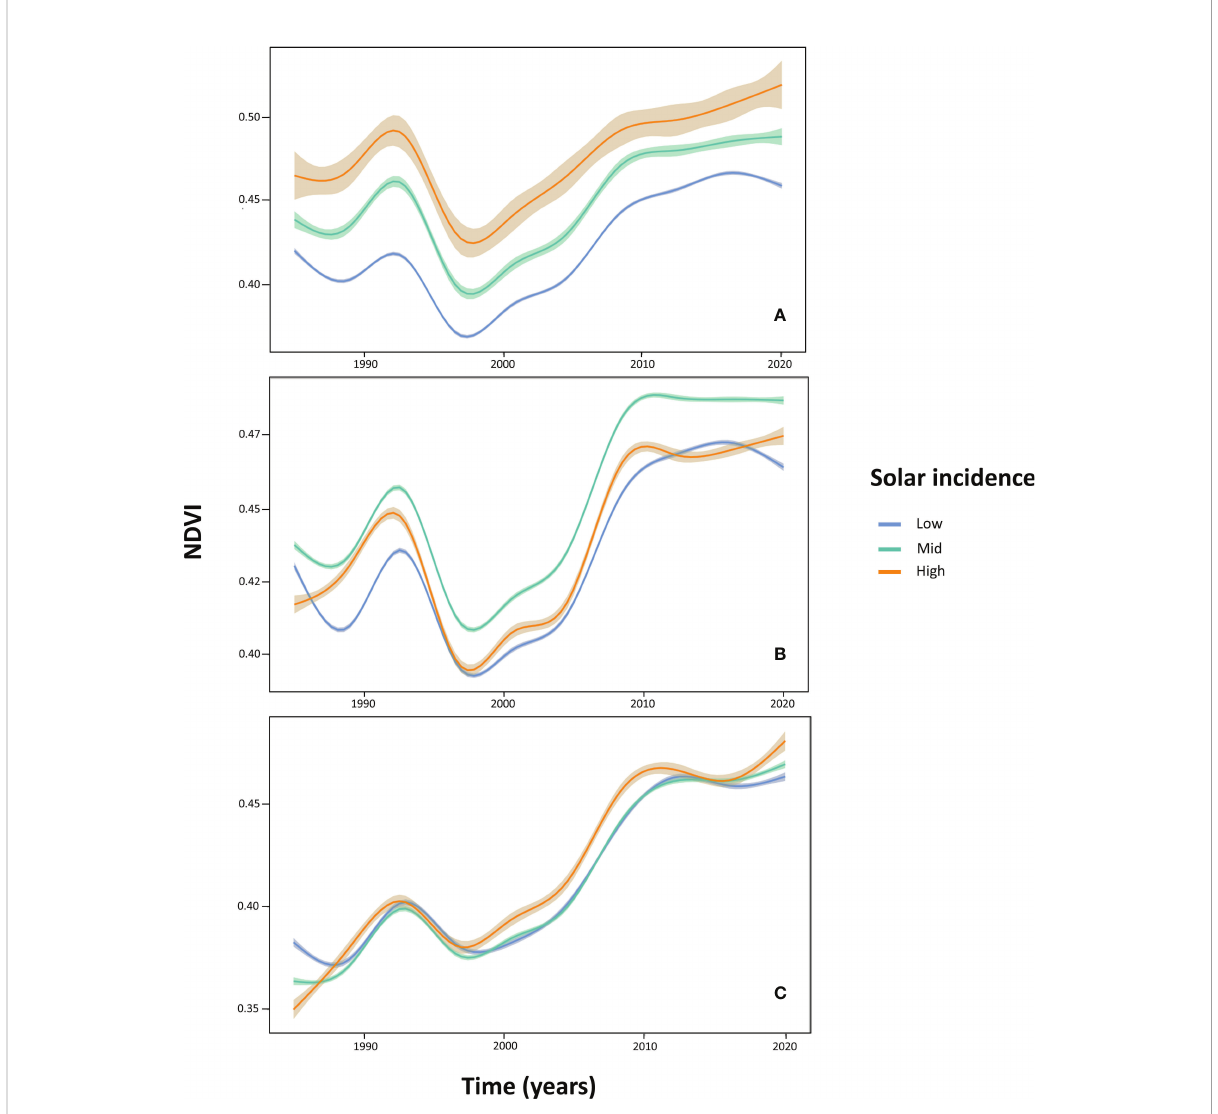
FIGURE 5 NDVI dynamics at the low (880-1150 m; graph A ), mid (1150-1350 m; graph B ), and high (1350-1550 m; graph C ) altitudinal bands, depending on November solar radiation incidence-SI levels ( ‘ Low ’ level: in blue, 0-46 hours of solar incidence; ‘ Mid ’ : in green, 46-130 hours; ‘ High ’ : in red, 130-175 hours). GAM smoothing was applied to NDVI curves, and shaded areas represent the amount of variation in NDVI values (95% con fi dence